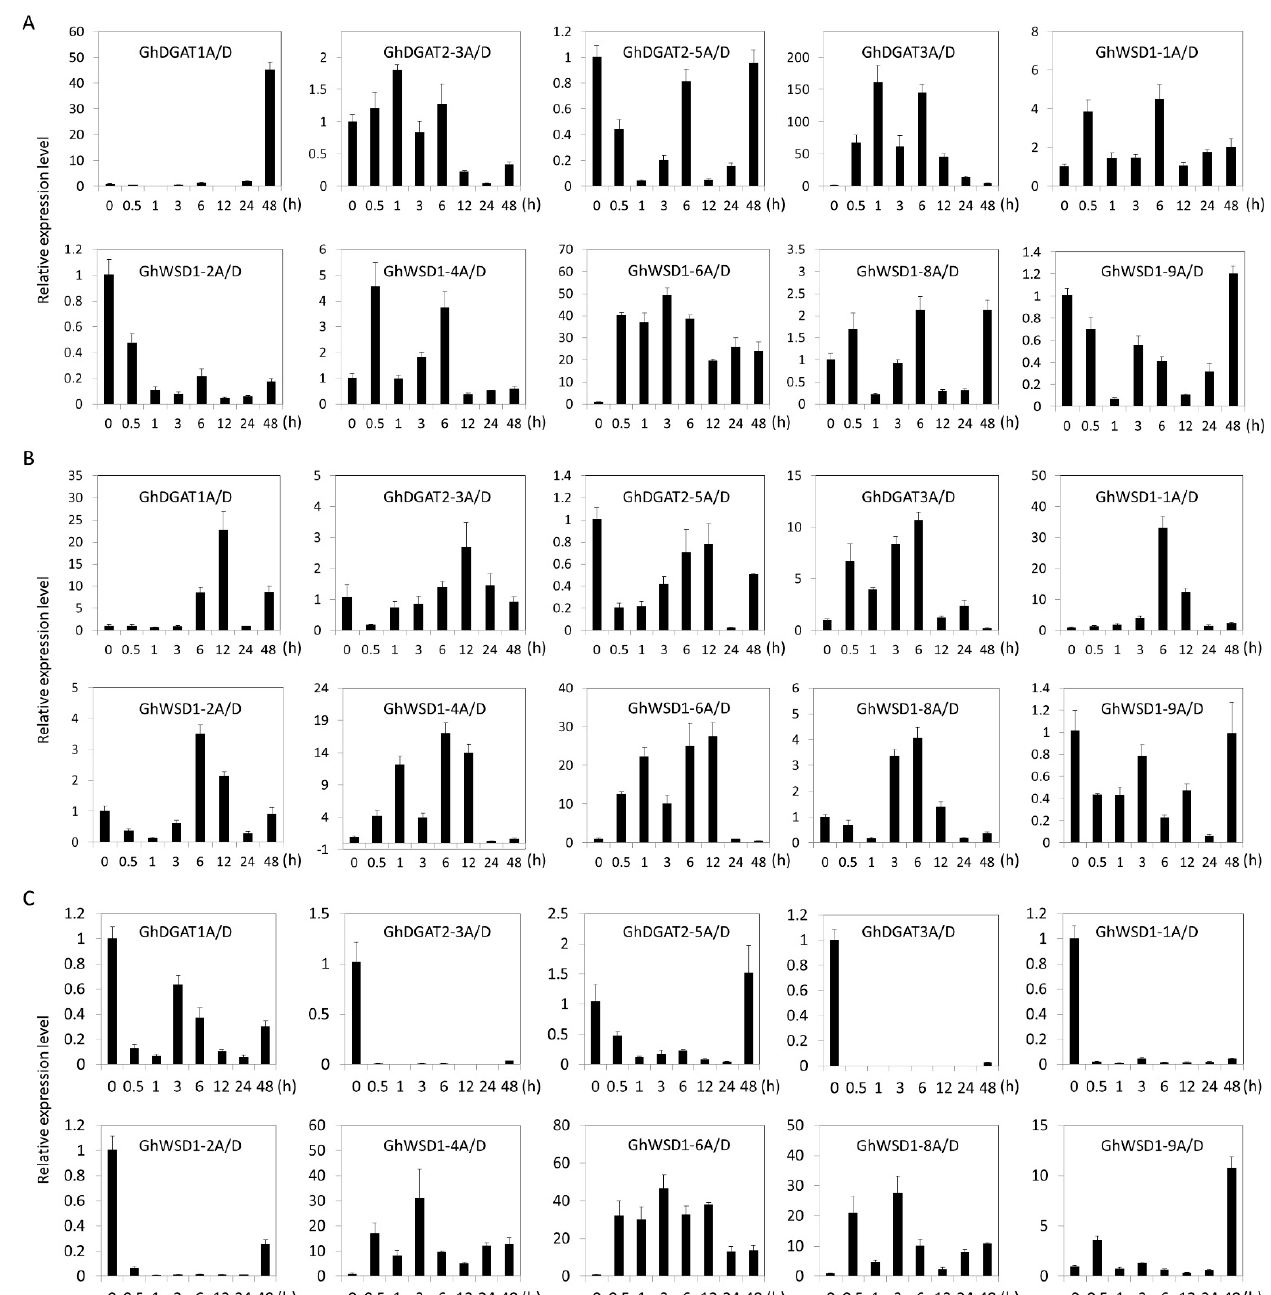
Figure 7. Expression profiles of GhDGAT and GhWSD1 genes during abiotic stresses; ( A ) gene expression patterns under cold stress; ( B ) gene expression patterns under drought stress; ( C ) gene expression patterns under salt stress. Cold: 4 °C; drought: 17% PEG-6000; salt: 200 mM NaCl.